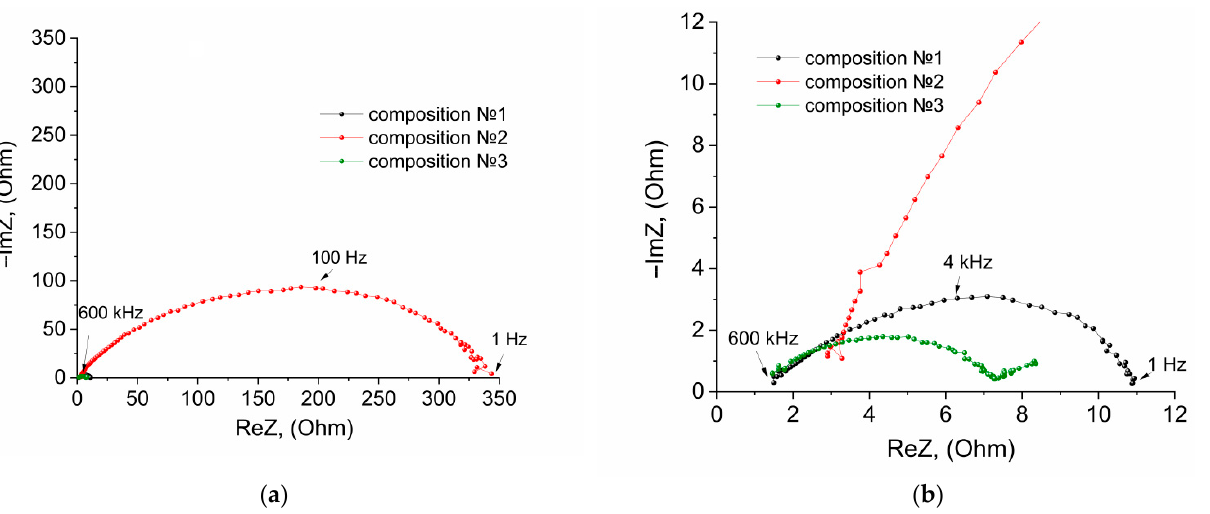
Figure 1. Nyquist plots of the impedance of the LiFePO 4 //LiFePO 4 cells, where ( a ) general view and ( b ) view on an enlarged scale. Composition: (1) LiFePO 4 /NPE/LiFePO 4 ; (2) LiFePO 4 /NPE/LiBF 4— GBL/LiFePO 4 ; (3) LiFePO 4 /NPE/LiTFSI—DOL-DME/LiFePO 4